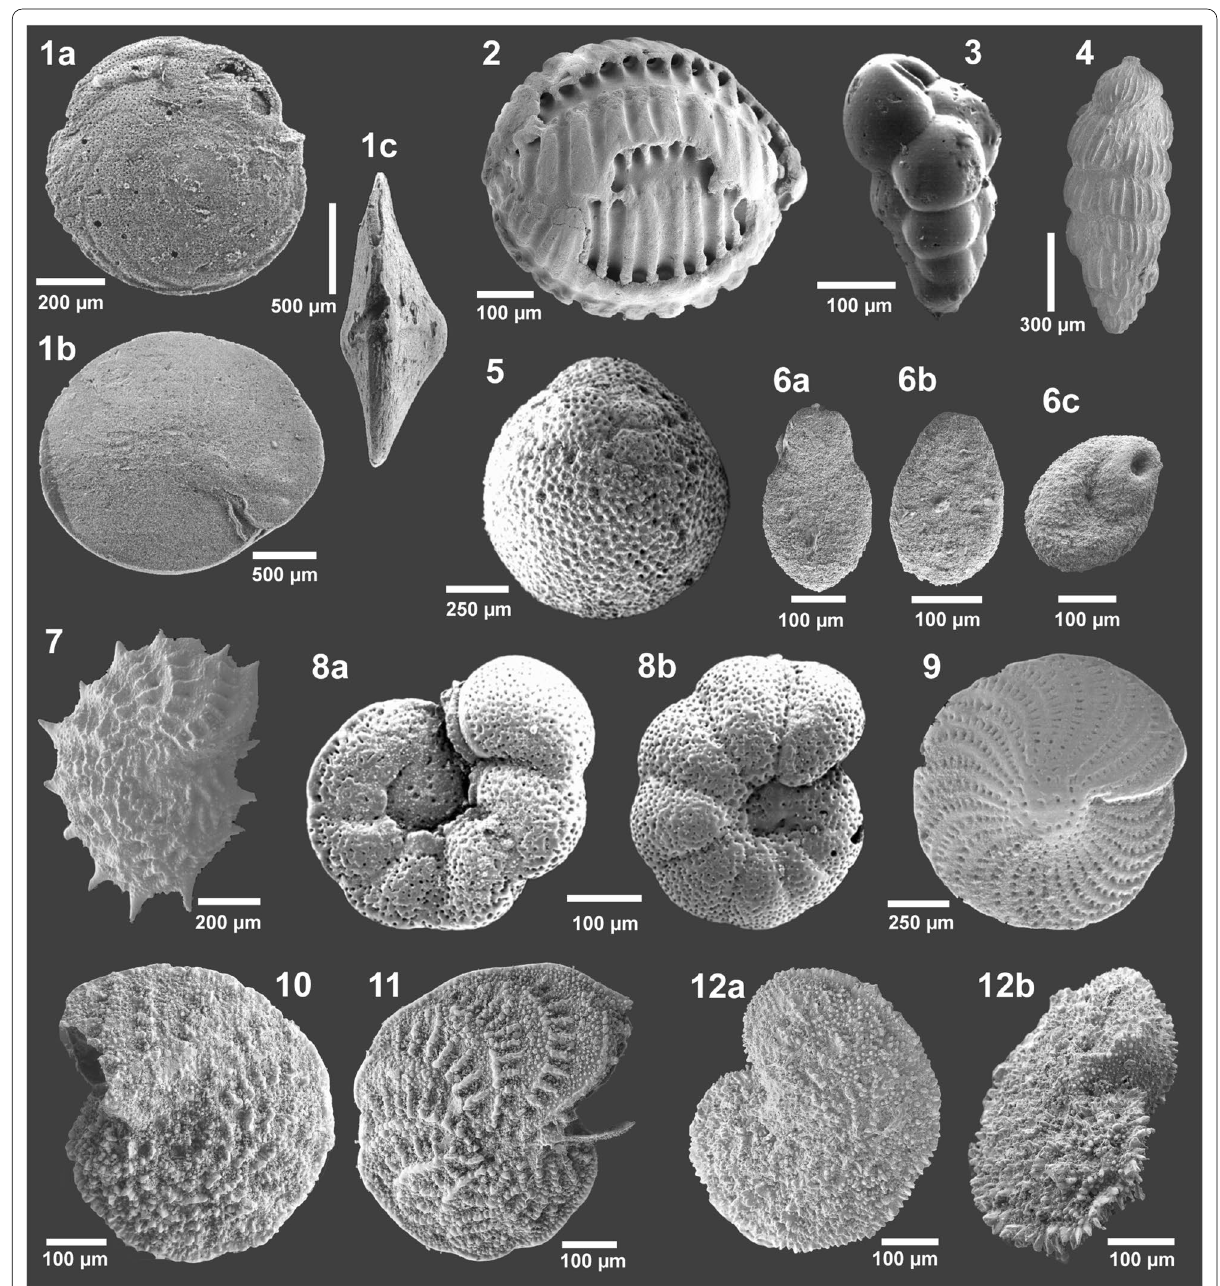
Fig. 10 Isolated foraminifera from upper Badenian and lower Sarmatian sediments. 1. Amphistegina mammilla (Fichtel & Moll, 1798), a: spiral view, b: umbilical view, c: lateral view, upper Badenian, sample HA 511/8; 2. Borelis melo (Fichtel & Moll, 1798), upper Badenian, sample HA 540/1; 3. Bulimina elongata (d’Orbigny, 1826), lateral view, upper Badenian, sample HA 573/9; 4. Pappina neudorfensis (Toula, 1900), lateral view, upper Badenian, sample HA 66/25; 5. Orbulina suturalis Brönnimann, 1951, upper Badenian, sample HA 511/5; 6. Saccammina sarmatica Venglinsky, 1958, a, b: lateral views, c: apertural view, lower Sarmatian, sample HA 573/3; 7. Elphidium aculeatum (d’Orbigny, 1846), lateral view, lower Sarmatian, sample HA 573/2; 8. Anomalinoides dividens Łuczkowska, 1967, a: spiral view, b: umbilical view, lower Sarmatian, sample HA 573/2; 9. Elphidium crispum (Linnaeus, 1758), lateral view, upper Badenian, sample HA 66/21; 10. Elphidium cf. subumbilicatum (Czjzek, 1848), lateral view, lower Sarmatian, sample HA 66/6; 11. Elphidium cf. grilli Papp, 1963, lateral view, lower Sarmatian, sample HA 66/6; 12. Elphidium cf. koberi Tollmann, 1955, a: lateral view, b: oblique apertural view, lower Sarmatian, sample HA